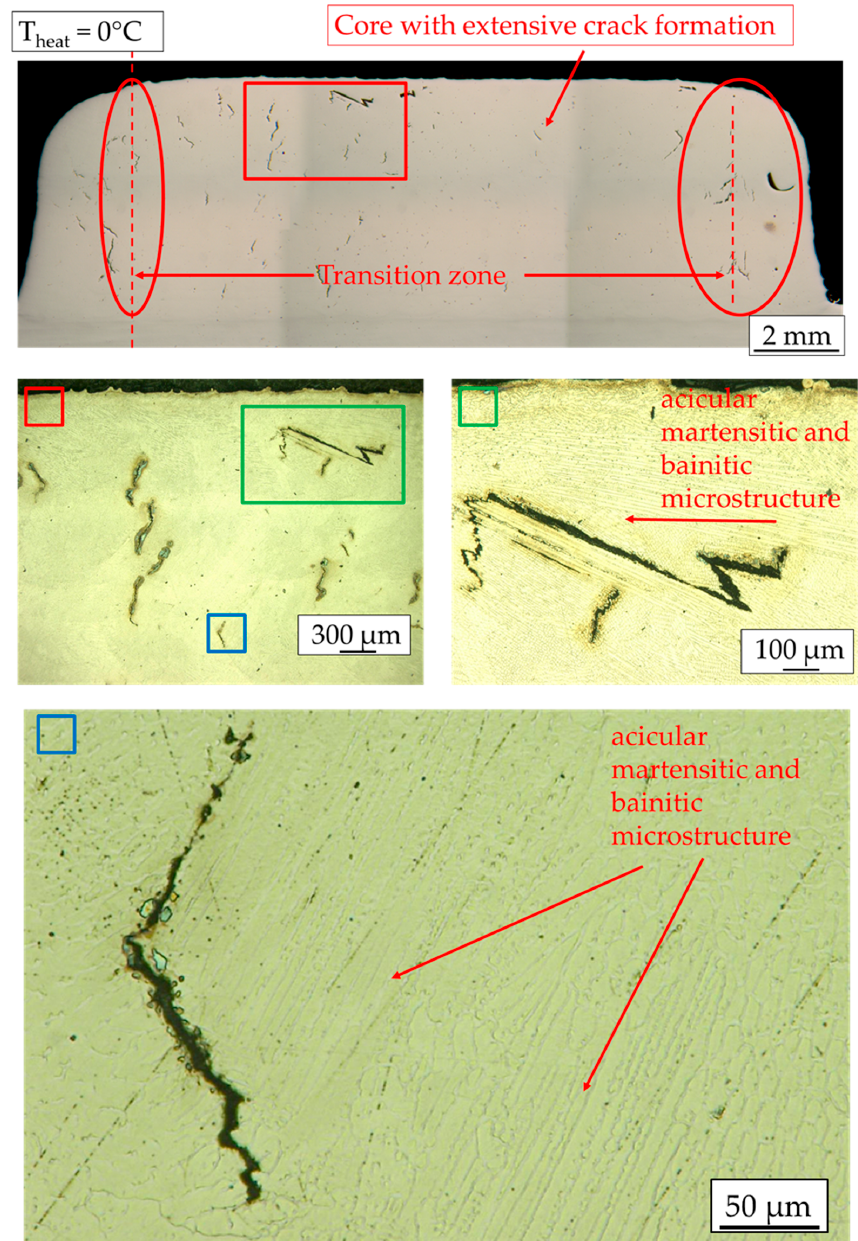
Figure A2. Cracks and microstructure in the core region of a cracked sample containing 0.5 wt. % carbon black nanoparticles manufactured without additional pre-heating (etching method V2A).